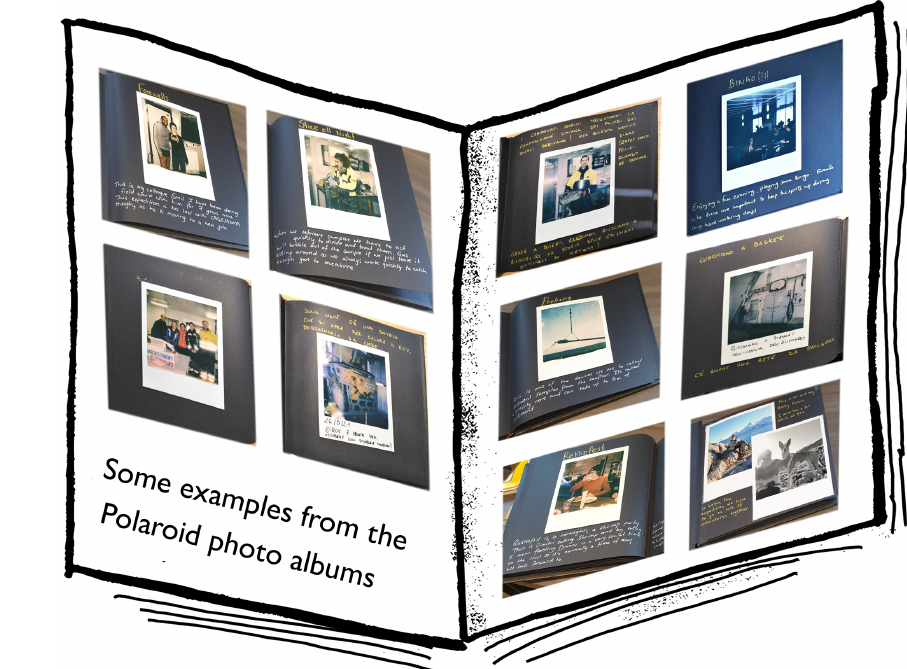
Figure 3. Some examples from the scientists’ Polaroid photo albums that they made for the classes they interacted with. The photos are simply meant to give an idea of how the albums were constructed. The captions are not meant to be readable in the present